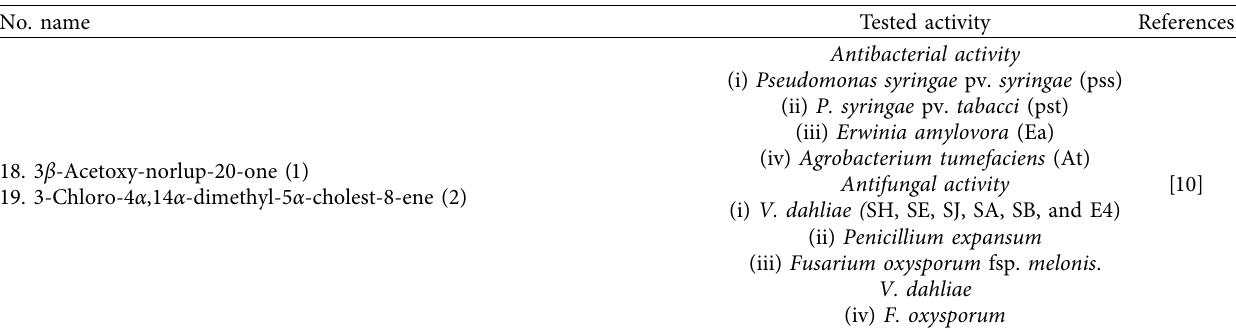
Table 2: Semisynthetic of new bioactive compounds from E. officinarum